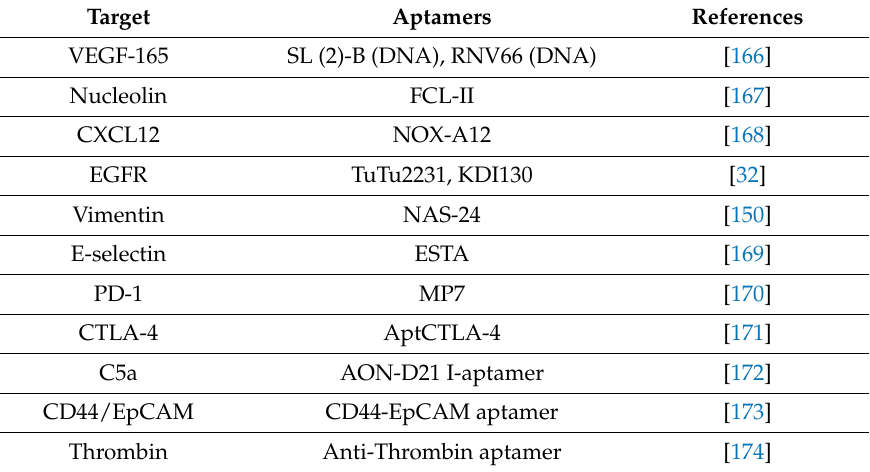
Table 4. Aptamer as